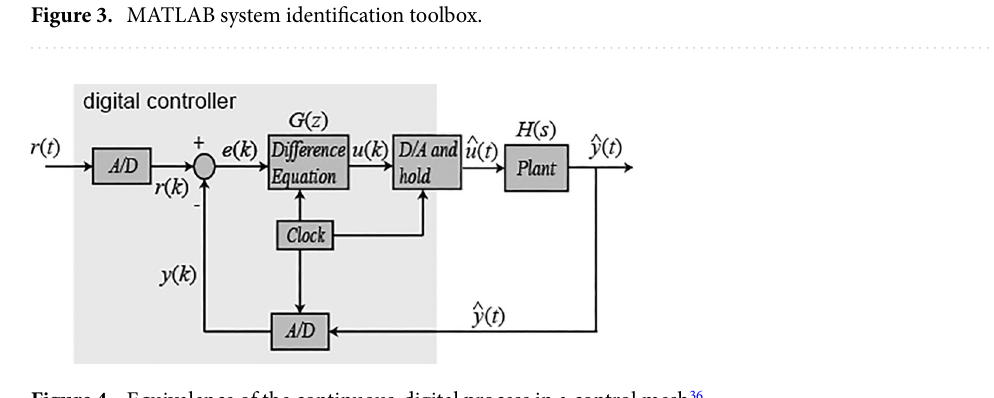
Figure 4. Equivalence of the continuous-digital process in a control mesh 36